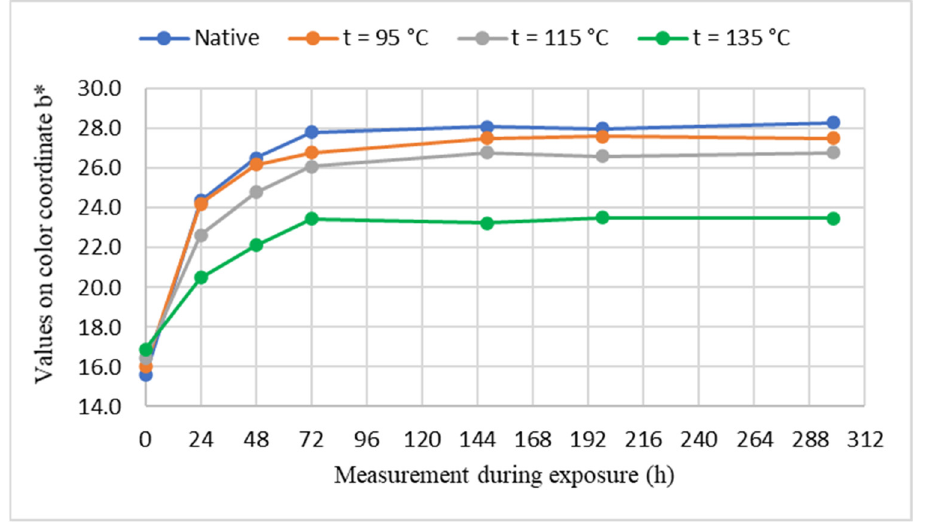
Figure 4. The course of changes of values on the coordinate of yellow color b* in the process of UV irradiation of samples.